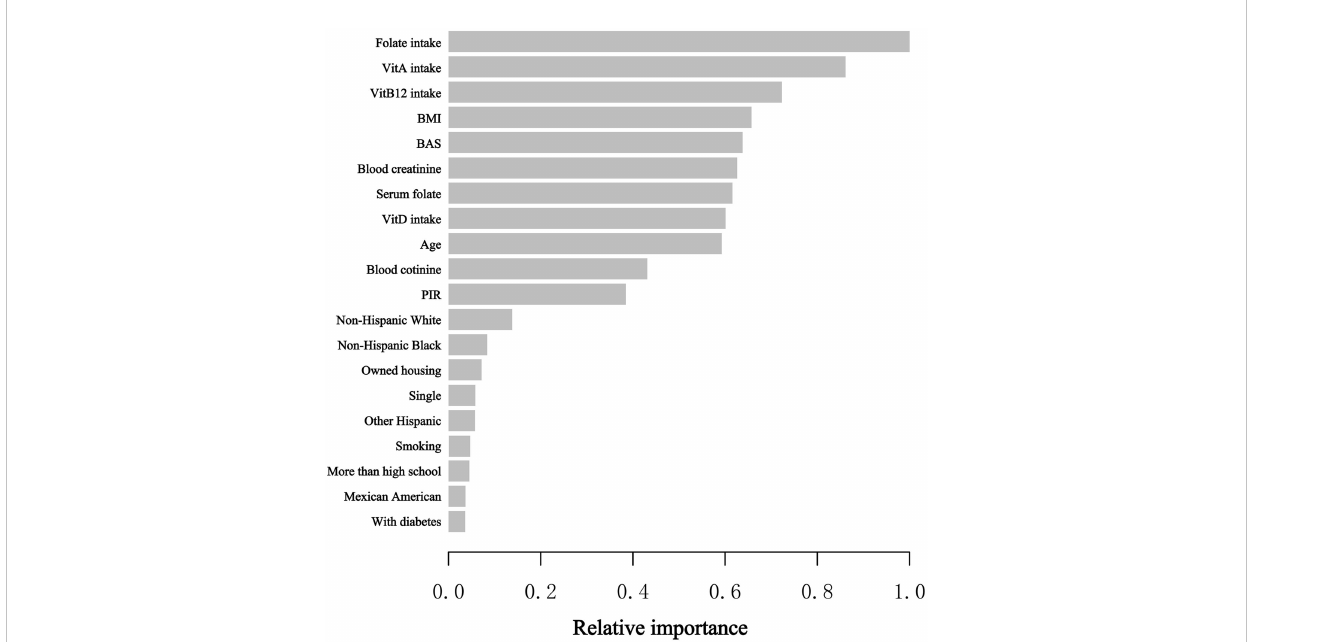
FIGURE 2 XGBoost model elucidates the relative signi fi cance of each variable on blood eosinophil counts and the corresponding variable signi fi cance score. The X-axis is the signi fi cance score, the relative number of a variable used to distribute the data; the Y-axis is the selected variables. PIR, poverty to income ratio; BAS, blood basophil counts; Vit, Vitamin.